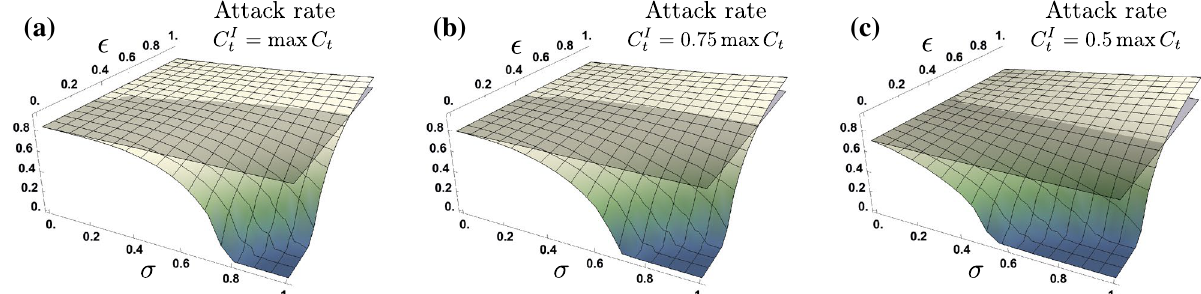
Figure 4. Attack rate as a function of the proportion of asymptomatic infections ( σ ) and their relative infectiousness ( ǫ ), for different contact rates of symptomatic individuals under adaptive behavior model. In panel ( a ) we assume symptomatic individuals maintain the privately optimal contact rate ( C in panel ( b ) we assume symptomatic individuals reduce their contact rate to 75% ( C in panel ( c ) we assume a contact rate reduction to 50% ( C precautionary measures by infectious individuals moderates the impact of non-symptomatic infections. The lower the symptomatic individuals’ contact rate, the greater the impact of non-symptomatic infections on the attack rate. Parameters τ = 14, ν = 0.1 , and ρ = 0.25 Panel (b) shows as expected, that the attack rate in the absence of asymptomatic infections under behavioral response (σ = 0 ) , is lower than the corresponding one under constant contact rates. Interestingly, under the